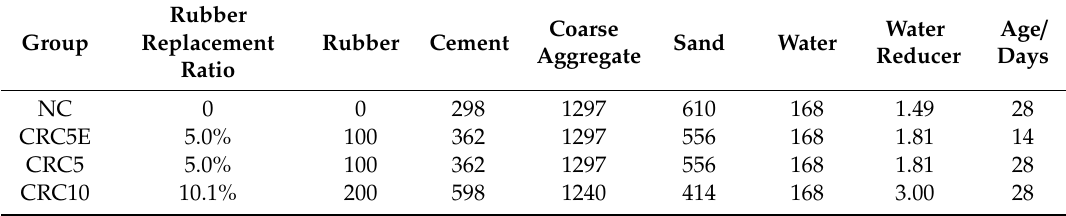
Table 1. Mix proportions of the concrete (kg / m 3 ). NC, normal concrete; CRC, crumb rubber concrete.